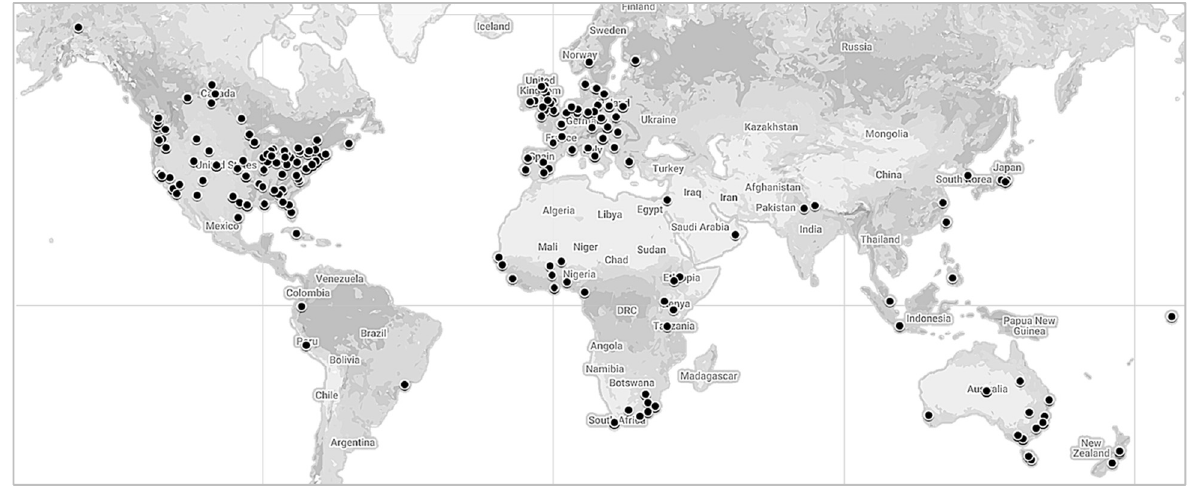
Figure 3. Studies by geographic region.